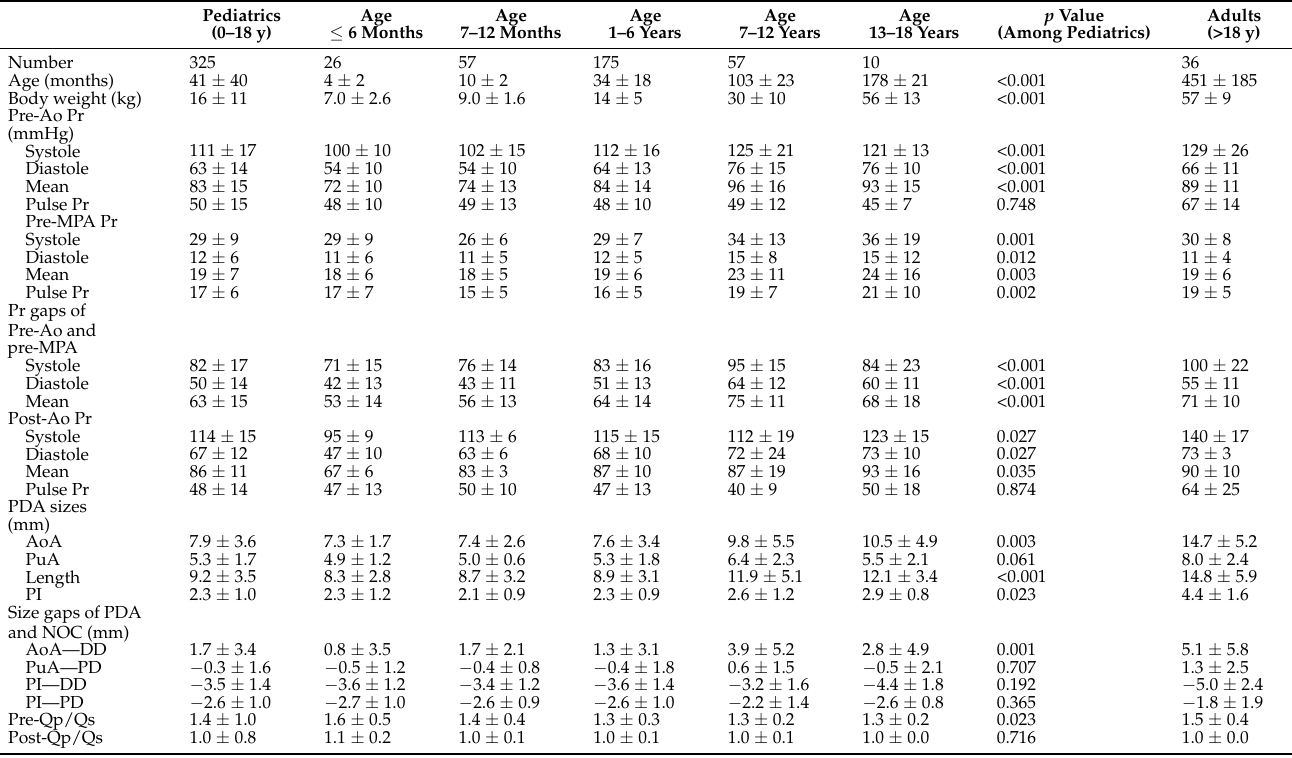
Table 1. Characteristics of subjects with PDA occluded by NOC according to the chronological age